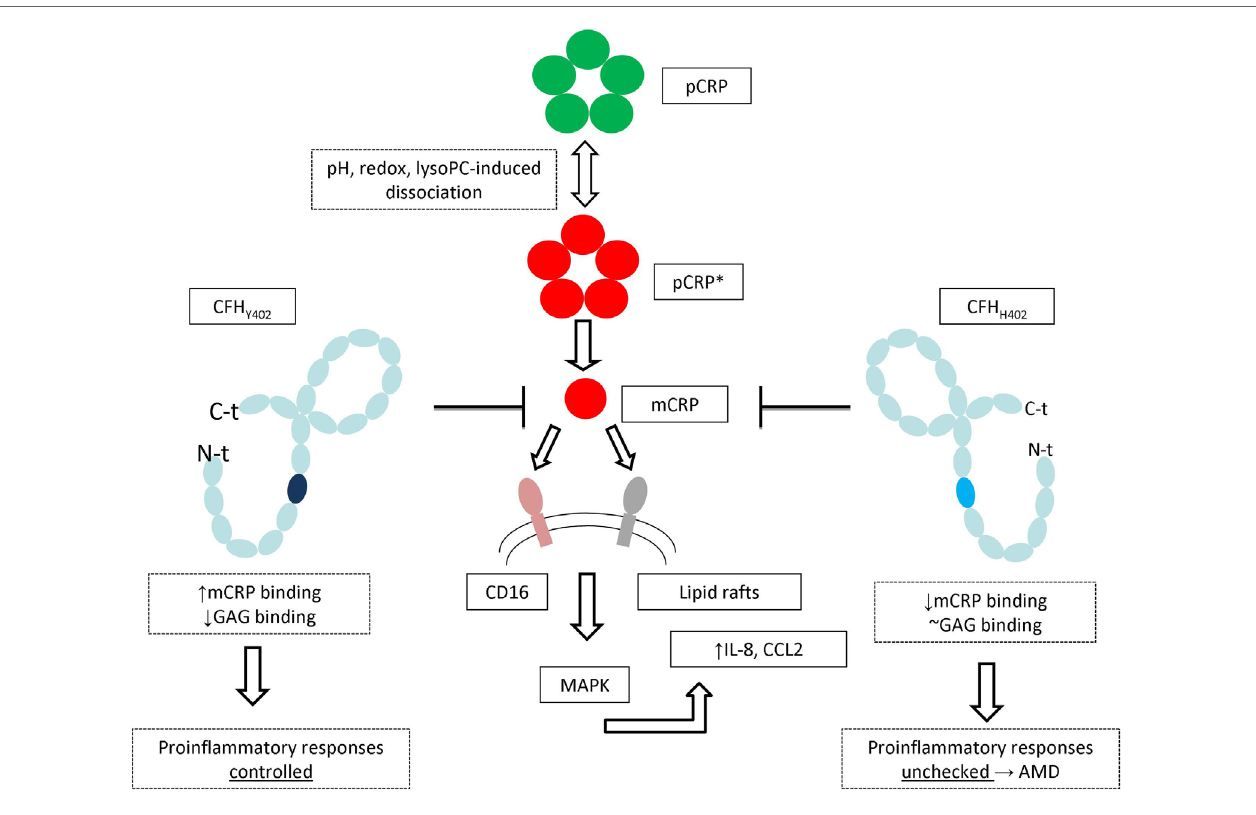
FiGURe 2 | A unified mechanism of mCRP-induced proinflammatory responses and the role of the CFH p.Tyr402His polymorphism in age-related macular degeneration (AMD). Generation of mCRP is accelerated in vivo under inflammatory conditions by bioactive lipids such as lysophosphatidylcholine (lysoPC) exposed on the surface of microparticles, activated or damaged cells. mCRP is recognized on the cell surface, leading to activation of MAPK pathways and ultimately enhances expression of proinflammatory cytokines and disrupts the outer blood retinal barrier. Binding of FH to mCRP attenuates this inflammatory response, but the FH H402 variant is less effective in this regard, both because of its altered binding to glycosaminoglycans (52), but, in particular, due to its markedly lower affinity for mCRP. The unchecked inflammatory response leads eventually to progression of AMD and vision loss [figure adapted from Molins et al.